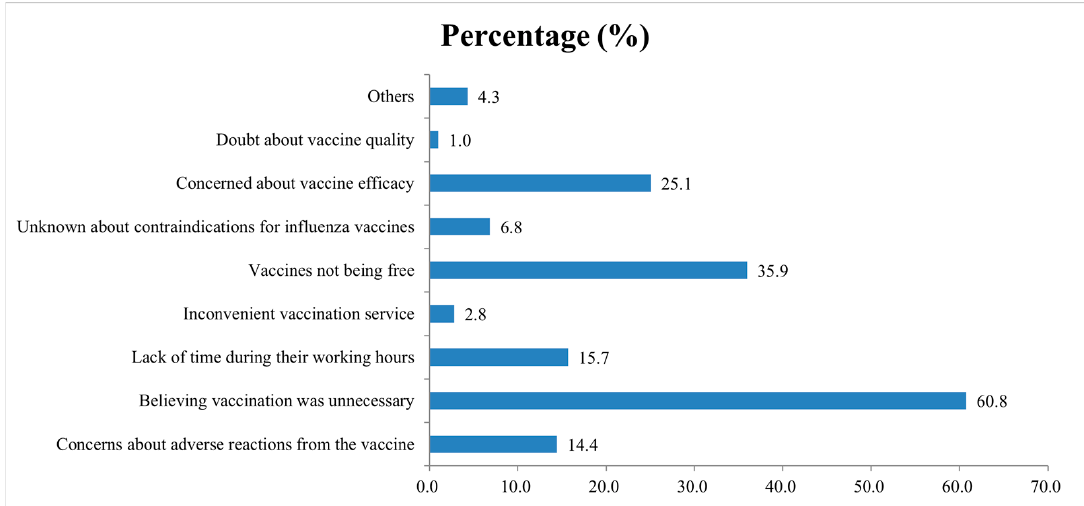
Figure 4. Proportion of reasons for not receiving the influenza vaccination among healthcare workers during the 2021–2022 season.